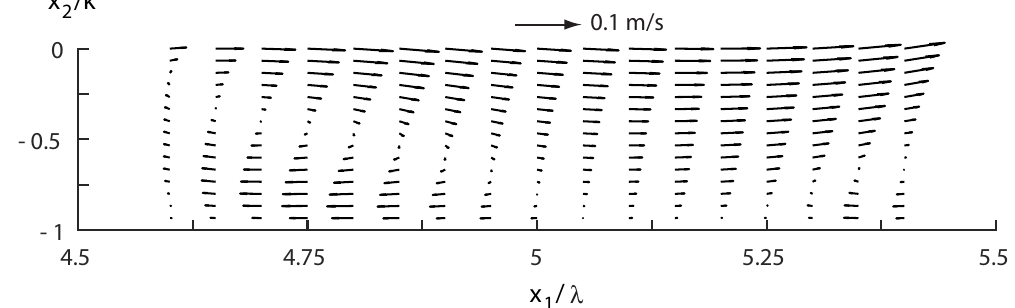
Figure 7. Vectors of predicted mean-flow velocities ( U 1 , U 2 ) in the cavity between the 5th and 6th bars for Run